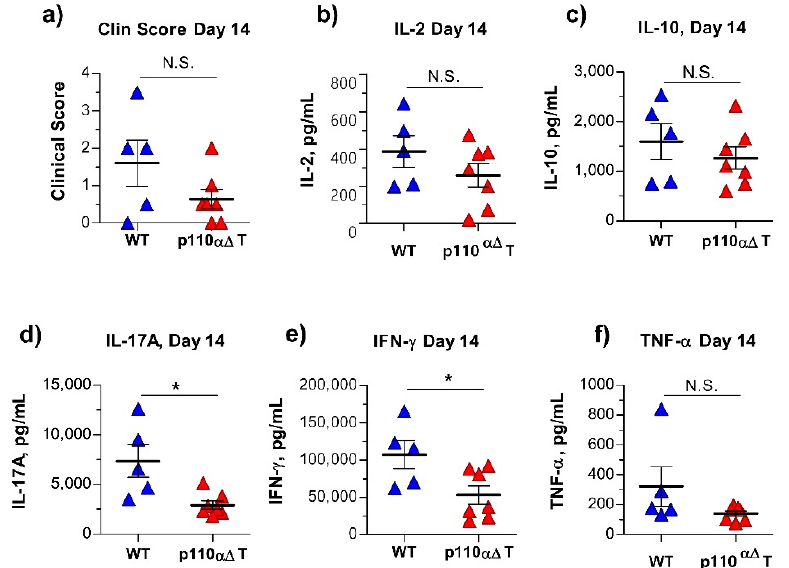
Figure 4. Secretion of cytokines by lymph node cells from individual mature wild type (WT) or p110 α ∆ T mice obtained after 14 days of Experimental Allergic Encephalomyelitis (EAE) induction with Myelin Oligodendrocyte Glycoprotein (MOG) peptide. Cells were cultured for 96 h in the presence of MOG peptide antigen, and cytokine content in the supernatants was determined. ( a ) clinical EAE score; ( b ) IL-2; ( c ) IL-10; ( d ) IL-17A; ( e ) IFN- γ ; ( f ) TNF- α . Data from mature WT ( n = 5), and p110 α ∆ T ( n = 7) mice are shown. Significant differences between groups are indicated, as determined with the Mann–Whitney U test ( a ), or the unpaired two-tailed Student’ t test ( b – f ). * p < 0.05; N.S.: not significant.